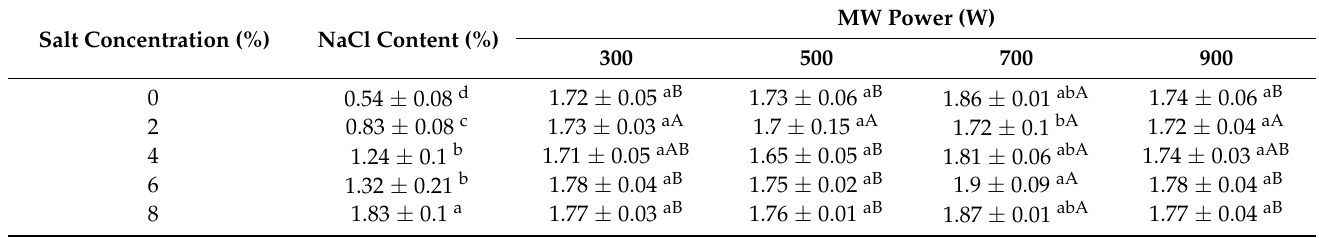
Table 2. Salt content of fresh shrimps after 8 h of curing with different salt concentrations and rehydration ratio of dried